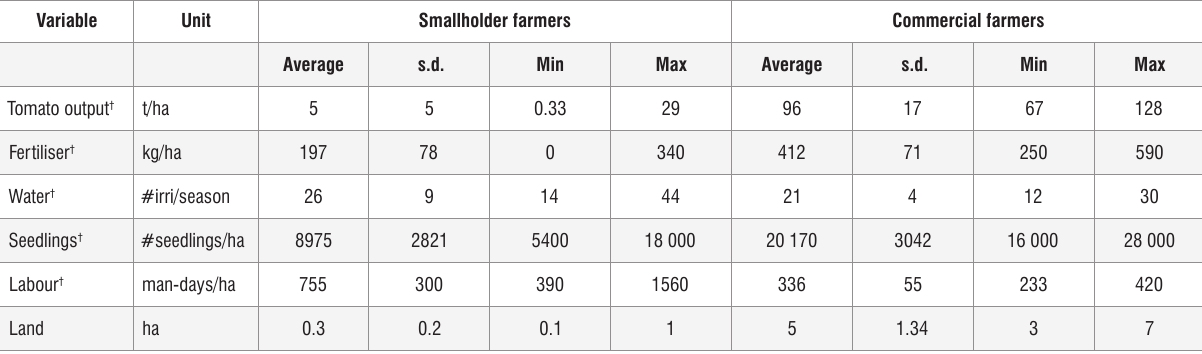
Average, standard deviation (s.d.), minimum (min) and maximum (max) tomato output and inputs used in estimation of technical efficiency